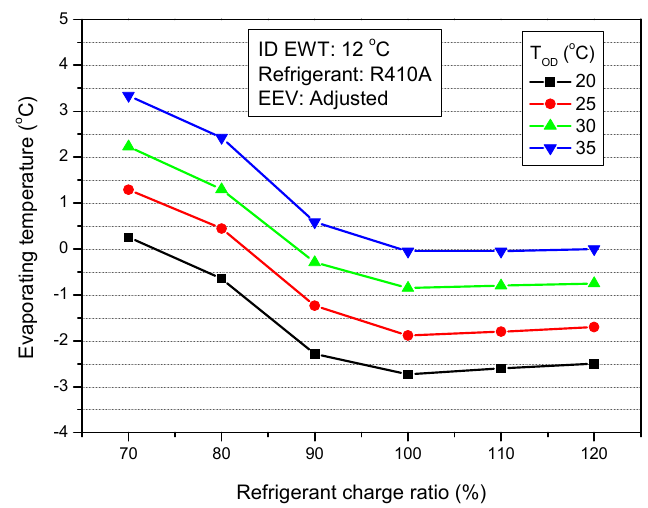
Figure 3. Evaporating temperature with variation of refrigerant charge amount and T OD .